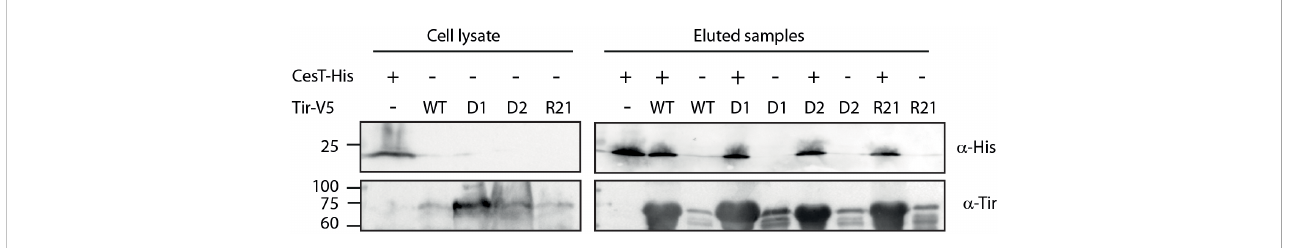
FIGURE 3 The Tir – CesT interaction is not disrupted by the replacement of Tir TMDs. E. coli BL21 (DE3) expressing Tir wt -V5, Tir- D1 -V5, Tir- D2 -V5, Tir- R21 -V5, or CesT-His were grown for 6 h. The bacterial cells were collected, lysed, mixed, and incubated overnight with nickel beads. Bacterial lysates and eluted fractions were loaded on a 12% SDS-PAGE gel and analyzed by western blotting with anti-His and anti-Tir antibodies.